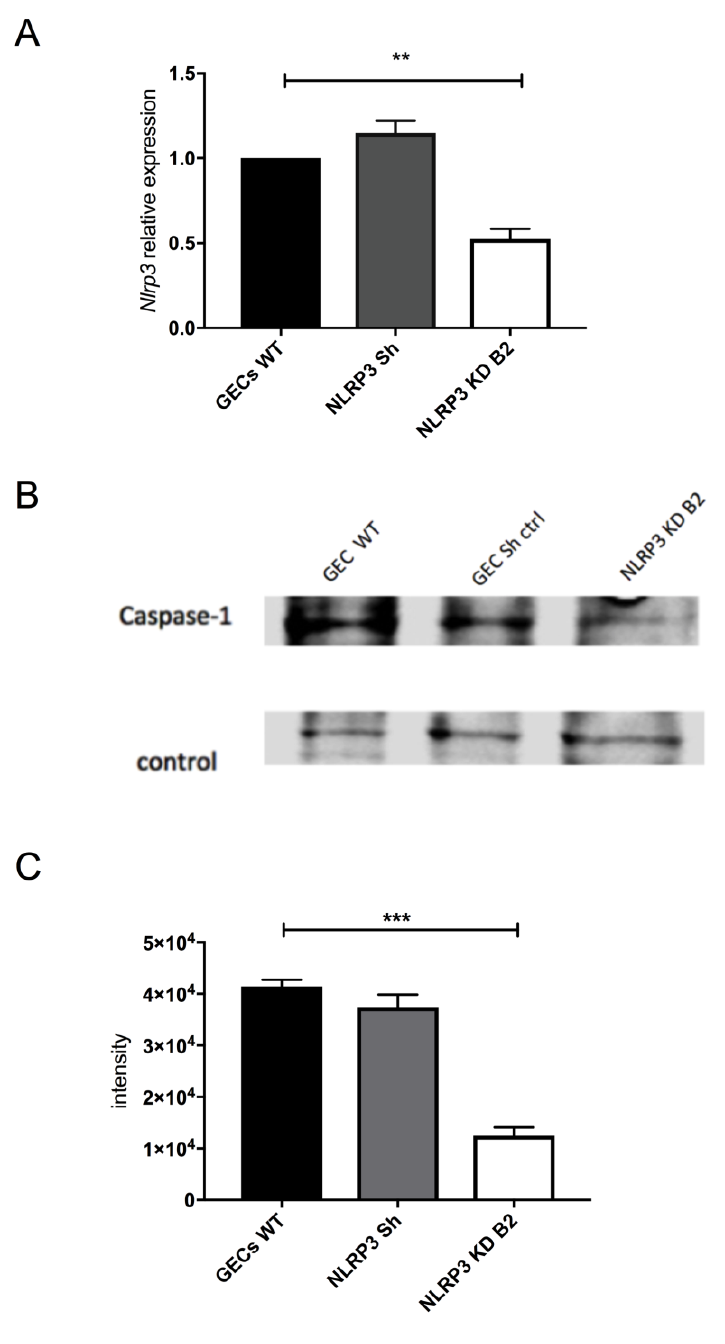
FIGURE 5: Inhibition of nlrp3 gene expression re- duces caspase-1 activation. (A) qPCR for nlrp3 gene expression was performed using RNA extracted from GECs transduced with lentiviruses carrying shRNAs targeting nlrp3 ( nlrp3 shRNA) or non- targeting control shRNAs ( ctl shRNA). qPCR assays were performed in triplicates, n = 4 independent experiments. Error bars represent ± SD; 2-sided, paired Student’s t test, ** P < 0.01. (B) Western blot representative image and (C) quantification of caspase-1 of supernatants from lentivirus- transduced GECs. Three independent experiments were performed; a representative blot is shown. Error bars represent ± SD; 2-sided, paired Stud ent’s t test, *** P <